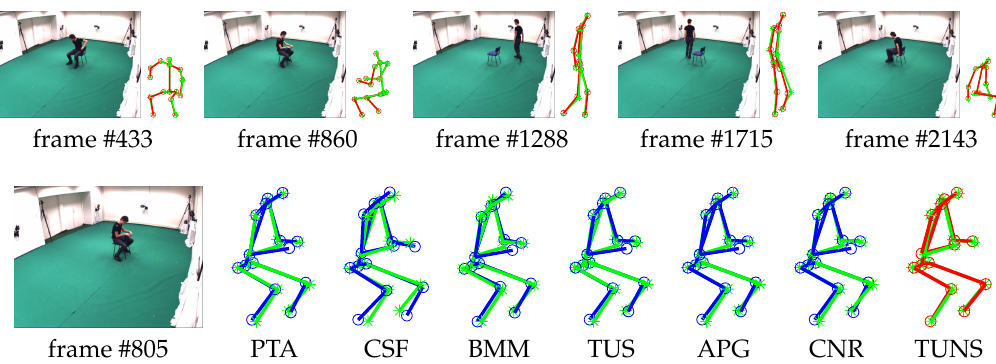
Figure 4. Evaluation on ’p1_chair_2’ sequence in UMPM. For five selected frames, our reconstruction (red skeleton), ground truth (green skeleton) and the corresponding image are shown on top. On the bottom, the reconstructions, yielded by all the baselines (blue skeleton) and our TUNS (red skeleton) of one specific frame, are shown with overlapping ground truth (green